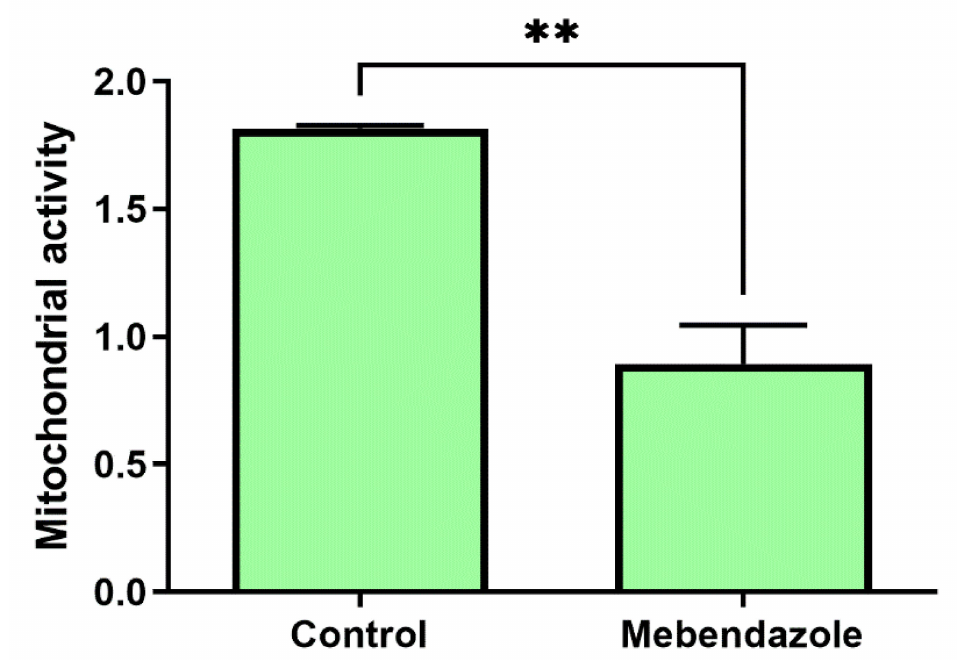
Figure 4. Mitochondrion metabolic activity of the H. capsulatum G271B strain after mebendazole treatment, as detected by the XTT assay. Mitochondrial activity was expressed by the difference in optical densities (OD) (450–660 nm), discounting the average of the OD of the blank (no fungal cells). Bars represent the mean and the standard deviation of three independent experiments read in duplicate. ** p < 0.01 (Student t